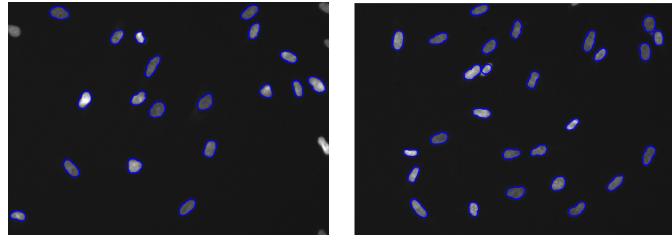
Figure 6. Nucleus detection and segmentation of DAPI images. The watershed transform separates nuclei from each